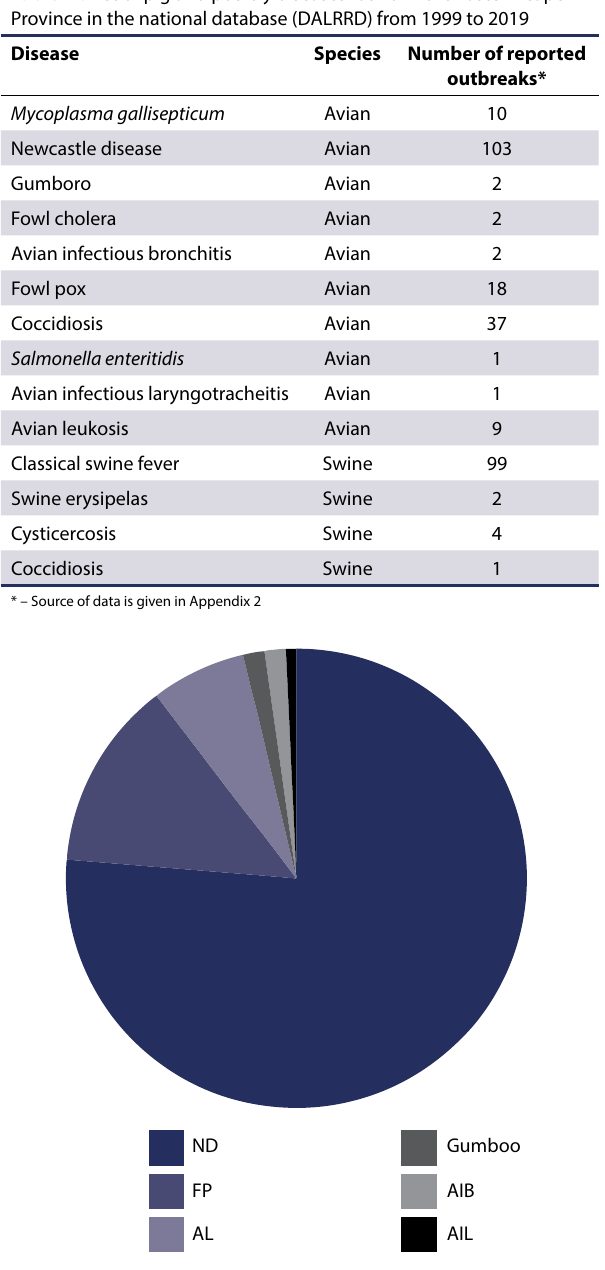
Figure 2 : Frequency of poultry viral diseases reported in the Eastern Cape Province from 1999 to 2019 in the national database (DALRRD): ND – Newcastle disease: 103 outbreaks, FP – fowl pox: 18 outbreaks, AL – avian leukosis: 9 outbreaks, Gumboro and AIB – avian infectious bronchitis: 2 outbreaks, AIL – avian infectious laryngotracheitis: 1 outbreak